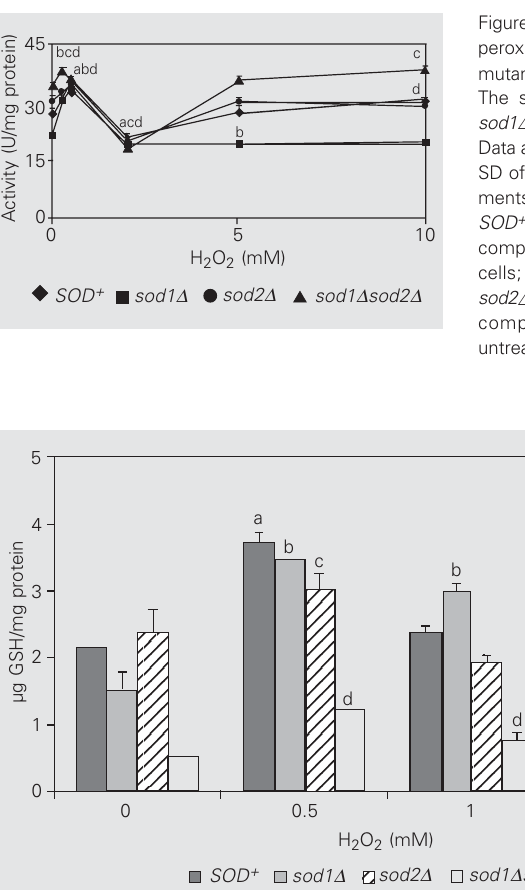
Figure 5. Total glutathione (GSH) content of wild-type and sod mutant cells exposed to H 2 O 2 . The total GSH was monitored by a microbiological method that uses a GSH auxotrophic yeast strain as a sensor for the presence of GSH, GSSG and γ -Glu-Cys. Data are reported as the mean ± SD of two independent experiments. a P < 0.05 compared to SOD + -untreated cells; b P < 0.05 compared to sod1 ∆ -untreated cells; c P < 0.05 compared to sod2 ∆ -untreated cells; d P < 0.05 compared to sod1 ∆ sod2 ∆ -untreated cells (Student t -